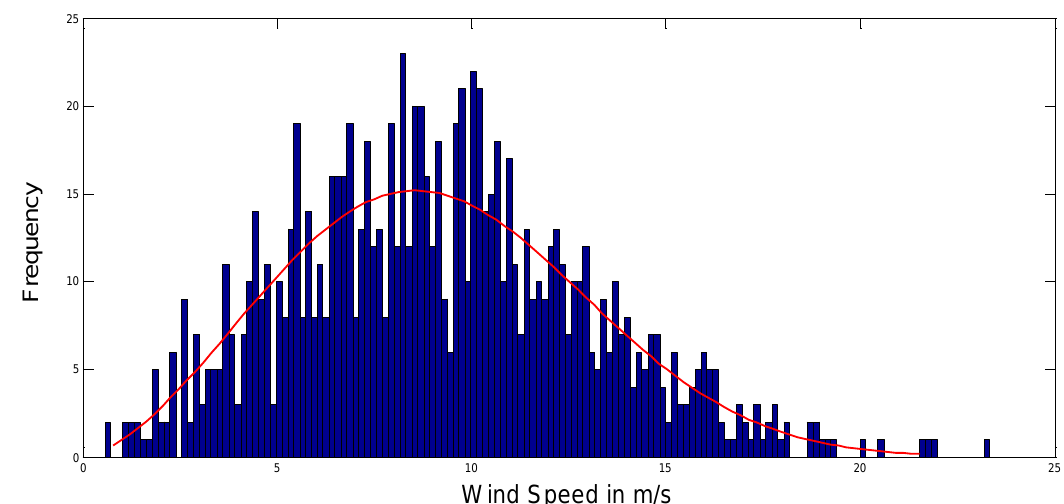
Figure 1. Weibull PDF ( 𝛼 = 10.5, 𝛽 = 2.6) for WT generator and a 1000 Monte Carlo scenario for wind speed distribution.